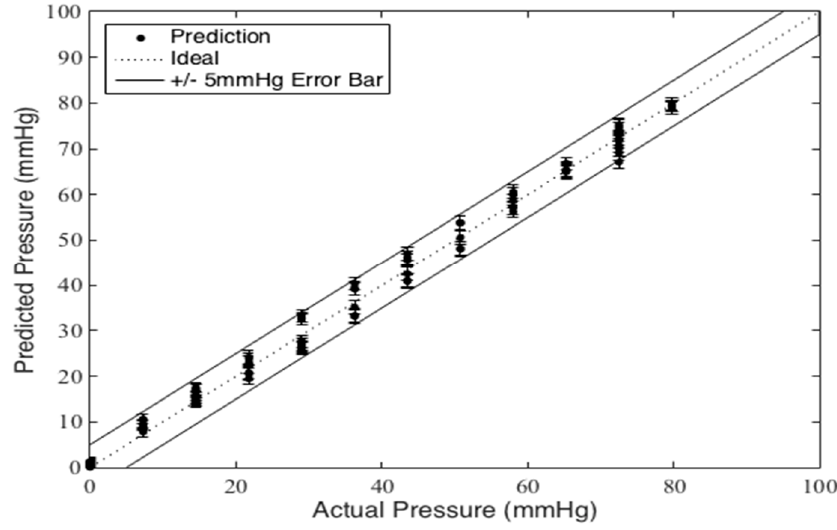
Figure 9. Predicted pressure compared to actual applied pressure in mass test.